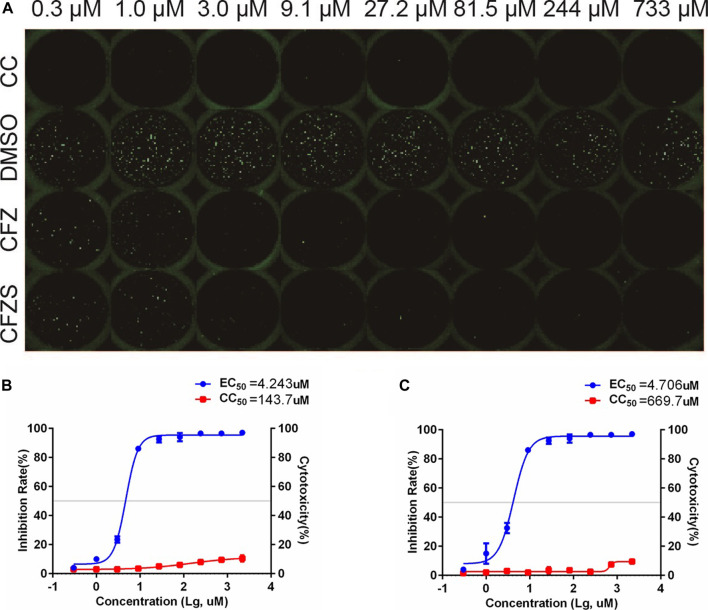
Anti-RABV activities of CFZ and CFZS in PG-4 cells. The RFFIT assay and EC50 of CFZ (A, B) and CFZS (A, C) in PG-4 cells.